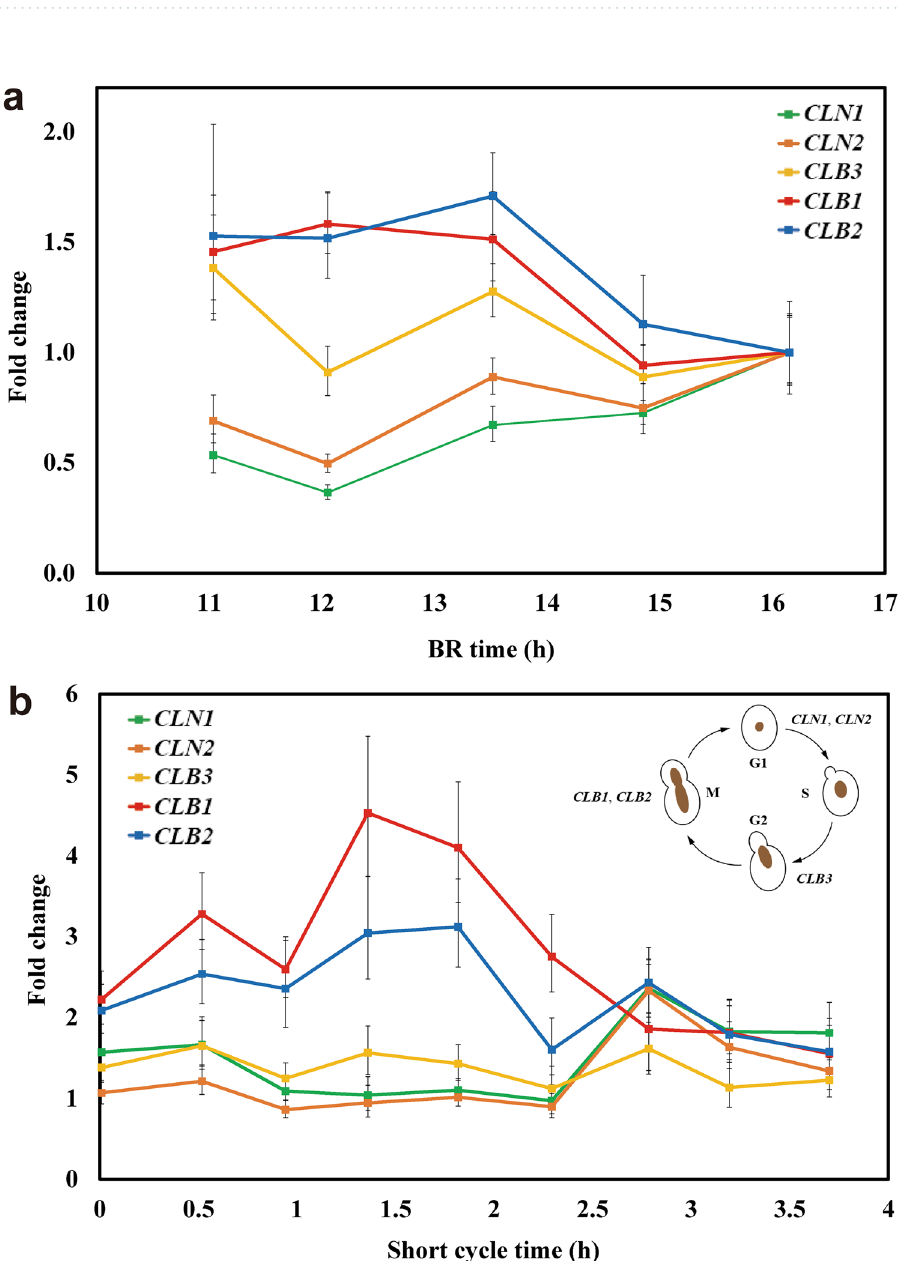
Figure 2. Relative expression of selected S. cerevisiae cyclin genes. ( a ) Fold changes of CLN1 , CLN2 , CLB3 , CLB1, and CLB2 during BR late-log phase. ( b ) Fold changes of the same cyclin genes during SCF short cycle 21 (the top-right schematic illustrates the expression sequence of the cyclin genes in regular cell cycle 25–28 ). ACT1 and ALG9 were used as reference genes, and a sample collected at 16.2 h during BR was used as the reference sample. Error bars show one standard deviations (n =